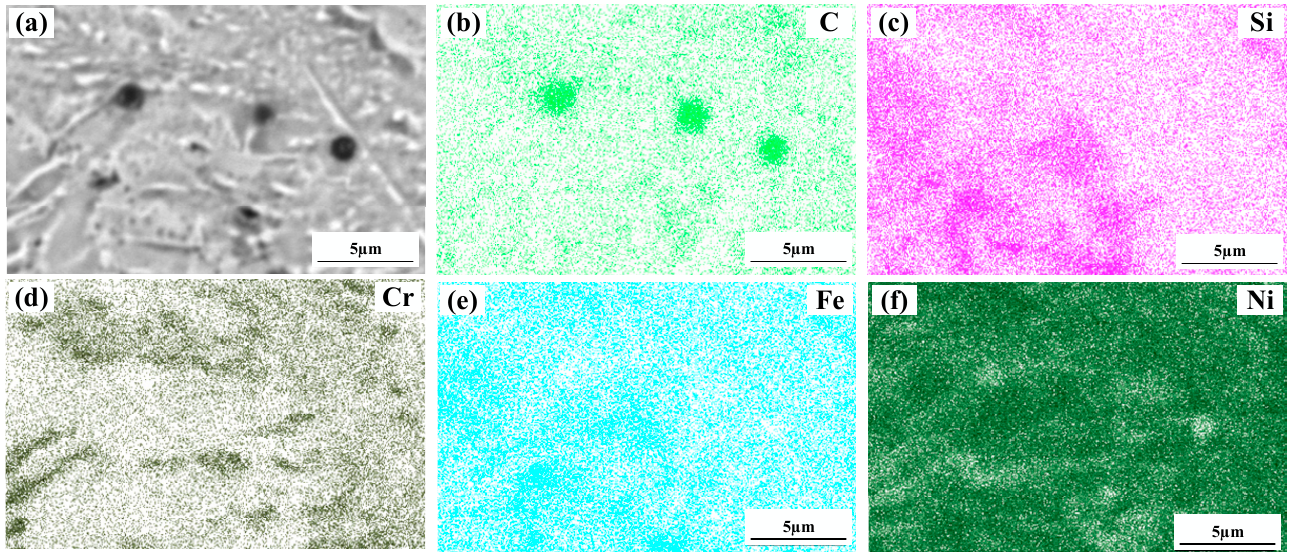
Figure 7. Composition analyses of surface scanning for specimen 3 (1% graphene content): ( a ) SEM image; ( b ) C; ( c ) Si; ( d ) Cr; ( e ) Fe; ( f ) Ni.